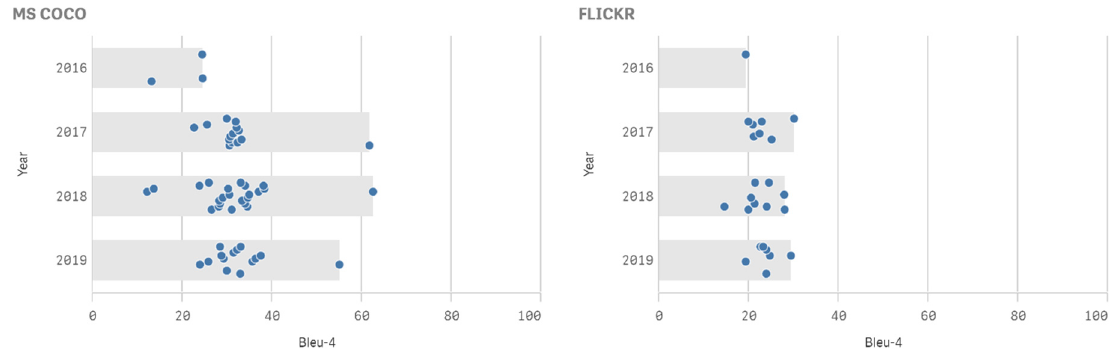
Figure 4. Bleu-4 results by year on MSCOCO ( left ) and Flickr30k ( right ).